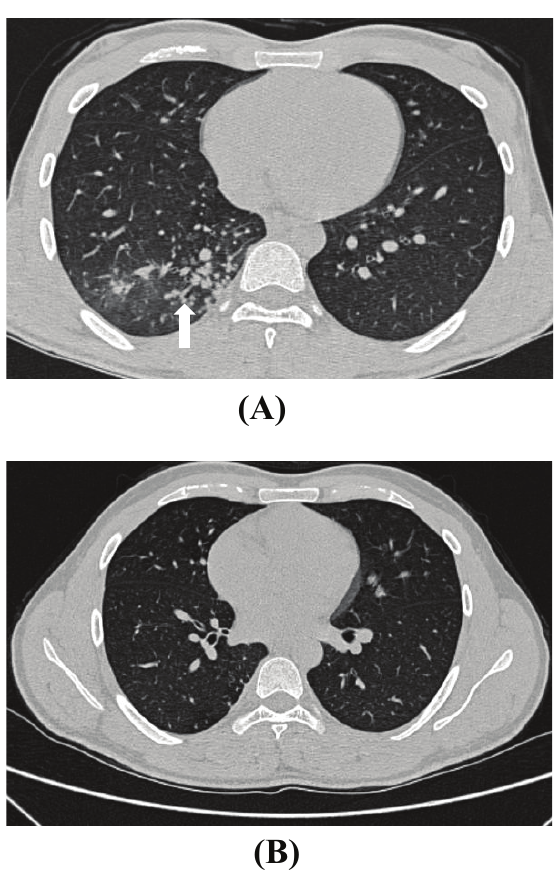
Figure 1 : Axial section of HRCT lung in a case of tuberculosis before and after treatment. (A) Pretreatment scan shows multiple centrilobular nodules getting confluent at places and giving tree-in-bud appearance (white arrow) in posterior segment of right lower lobe. (B) Posttreatment HRCT scan shows complete disappearance of tree-in-bud